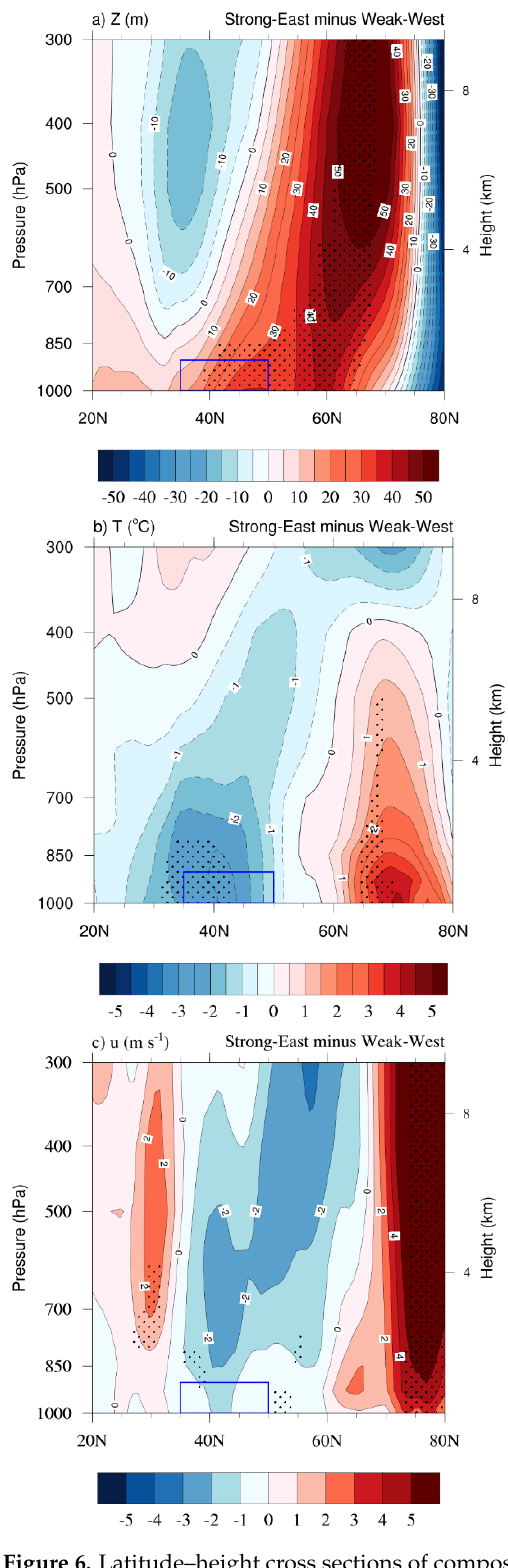
Figure 6. Latitude–height cross sections of composite differences in ( a ) geopotential height (Z, m), ( b ) air temperature (T; °C), ( c ) zonal-mean wind (u; m s − 1 ) between the Strong-East and Weak-West periods averaged over 95°–110° E (R1 and R2). Black dotted areas indicate where the differences are statistically significant above the 90% confidence level based on the Student’s t -test.